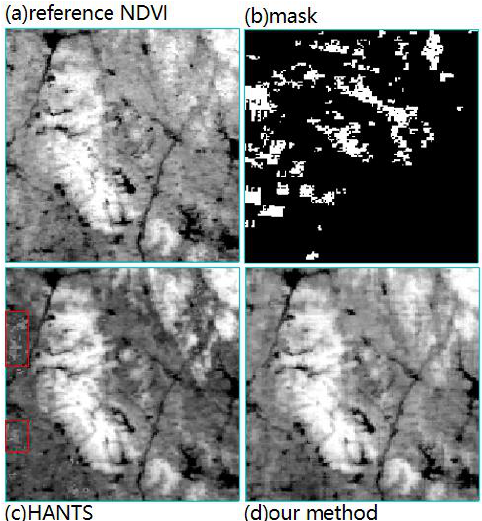
Figure 5. The first group of reconstructed NDVI.